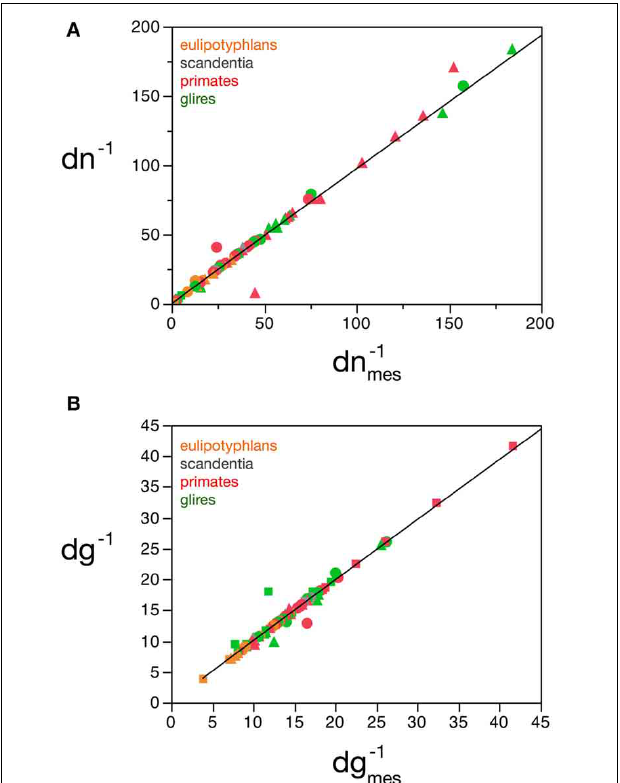
FIGURE 4 | Correspondence between measured and estimated cell densities. (A) Graphs show the correspondence between measured and estimated values for the inverse of neuronal density estimated by the model, d − 1 n , and the inverse of measured neuronal density, d − 1 nmes . (B) Correspondence between measured and estimated values for the inverse of glial density estimated by the model, d − 1 g , and the inverse of measured glial density, d − 1 gmes . Values expressed as picograms per cell, plotted for each species and brain structure: cerebral cortex (circles), cerebellum (squares) and rest of brain (triangles). Power fits plotted have exponents 0.991 ± 0.015, r 2 = 0 . 983, p < 0 . 0001 (A) and 0.987 ± 0.021, r 2 = 0 . 967, p < 0 . 0001 (B) . Data from Herculano-Houzel et al. (2006, 2007, 2011), Azevedo et al. (2009), Sarko et al. (2009), and Gabi et al. (2010).